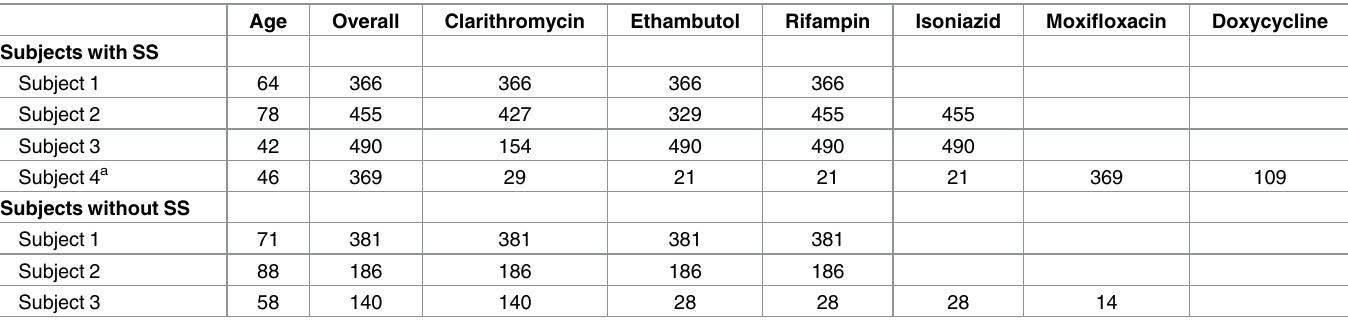
Table 4. Age and number of days of prescription anti-mycobacterial antibiotics given to the seven subjects with NTM